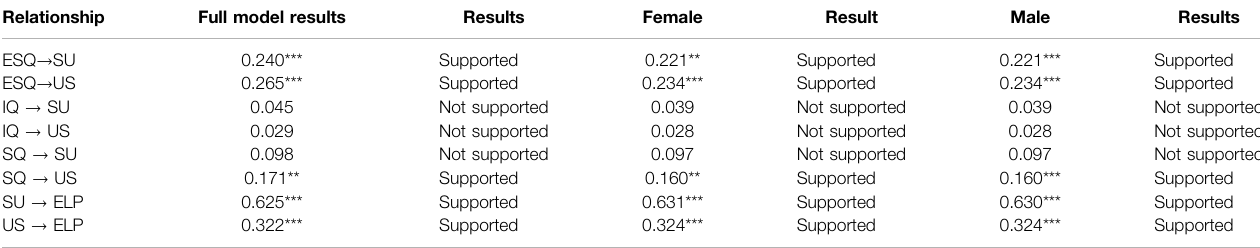
TABLE 10 | Comparison analysis. Relationship